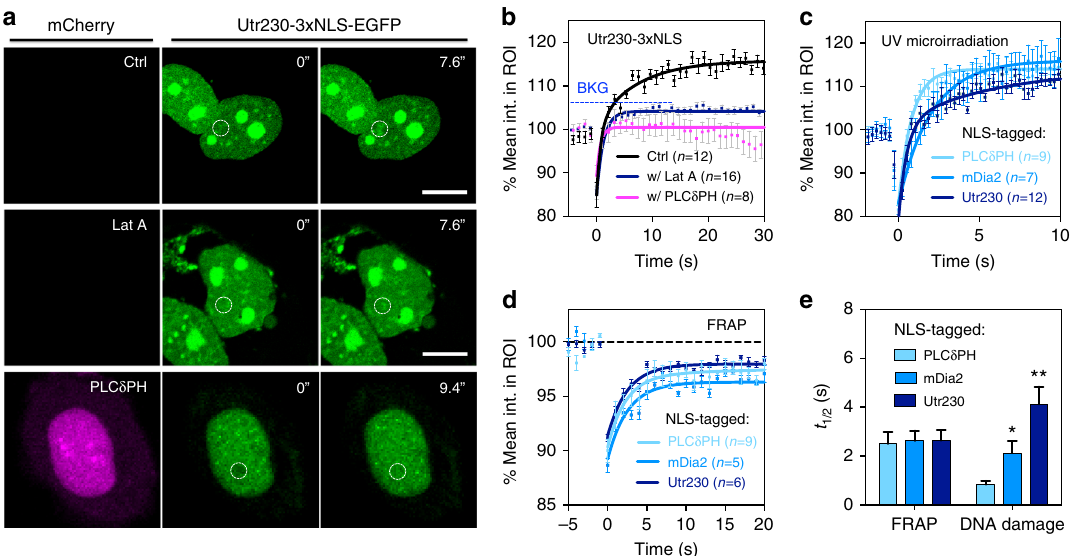
Fig. 6 Nuclear actin assembly follows the accumulation of PH domains and formins at damage sites and is inhibited by Lat A. a Confocal micrographs of U2OS cells expressing NLS-tagged Utr230-EGFP before and after laser microirradiation with or without 0.8 μ M Lat A or after the co-expression of 3xNLS- PLC δ -PH-mCherry. Dashed circles indicate the ROI for laser microirradiation b Corresponding quanti fi cation of mean fl uorescence intensity of Utr230 within the ROI in the absence or presence of Lat A, or the co-expression of PLC δ -PH in the nucleus. c The recruiting dynamics of NLS-tagged PLC δ -PH, mDia2 and Utr230 upon laser microirradiation in independent measurements. d Complementary FRAP measurements of the same three NLS-tagged proteins showed that all three proteins are equally diffusive in the nucleus. e Summarized half times for damage-induced accumulation and photobleaching recovery times of NLS-tagged PLC δ -PH, mDia2 and Utr230. Data are representative of three independent experiments for panel A&B and at least two independent experiments for panel C-E. Error bars represent mean ± s.e.m. in all panels. Student ’ s t -test, * p < 0.05; ** p < 0.01; *** p < 0.001. n. s. represents not signi fi cant. BKG represents background